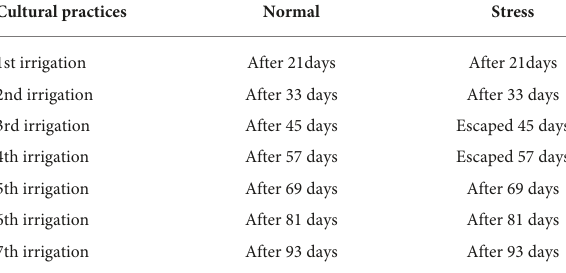
TABLE 2 The irrigation treatments for maize crop during 2018 and 2019